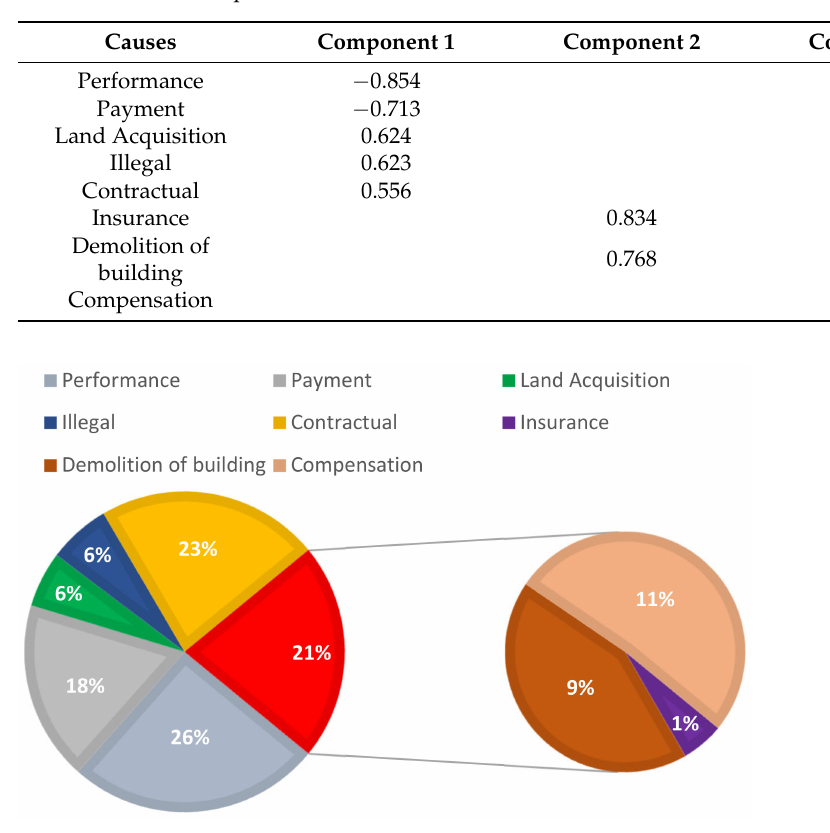
Figure 3. Pie chart representation of components and causes.